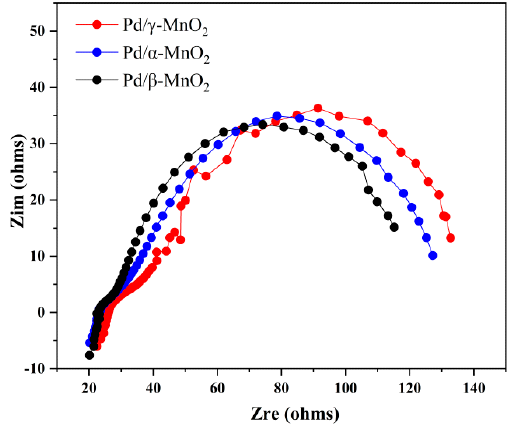
/ β -MnO / γ -MnO 2 , Pd 2 , and Pd 2 catalysts.